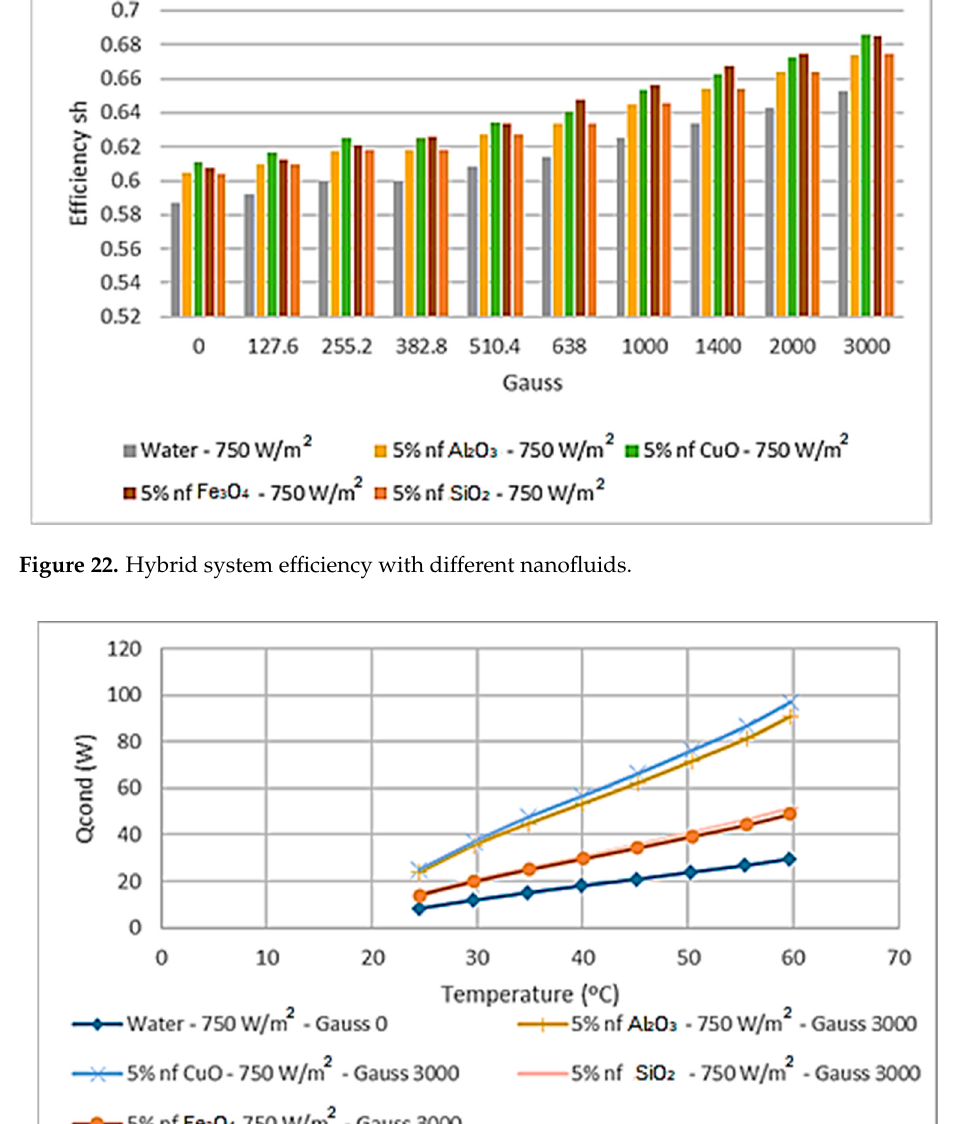
Figure 21. Thermal energy transferred to nanofluids from PV-Th solar panels.